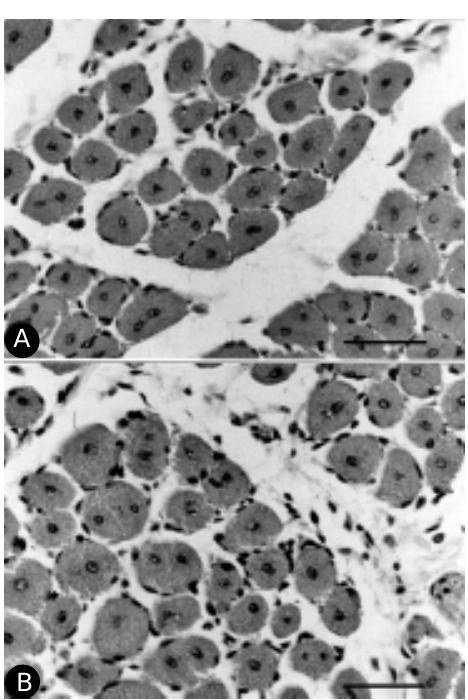
Figure 1. mdx regenerated muscle fibers with central cell nuclei after 20 (A) and 50 (B) bupivacaine injections. Hema- toxylin and eosin (bars = 150